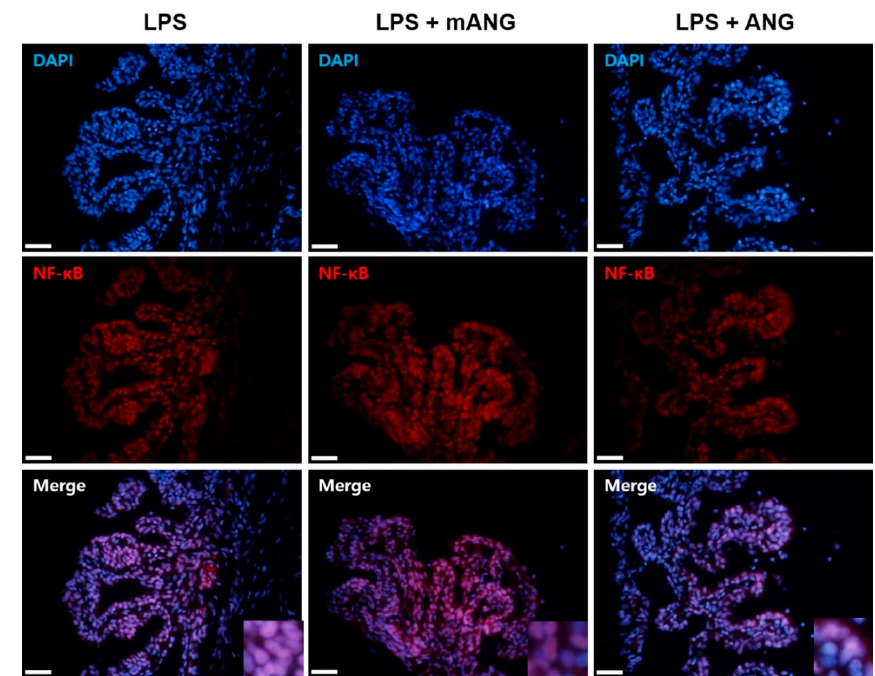
Figure 4. Immunofluorescent localization of NF ‐κ B. The presence of NF ‐κ B in the nuclei and cytoplasm of ciliary bodies of EIU eyes is shown in red. Fluorescent staining of the nuclei of fixed cells is shown as the control (DAPI) (blue). Merge images show the representative localization of NF ‐κ B (purple). Note the relatively higher ratio of NF ‐κ B in the nucleus in LPS than in ANG treated eyes. Scale bars = 200 μ m ( n = 5).